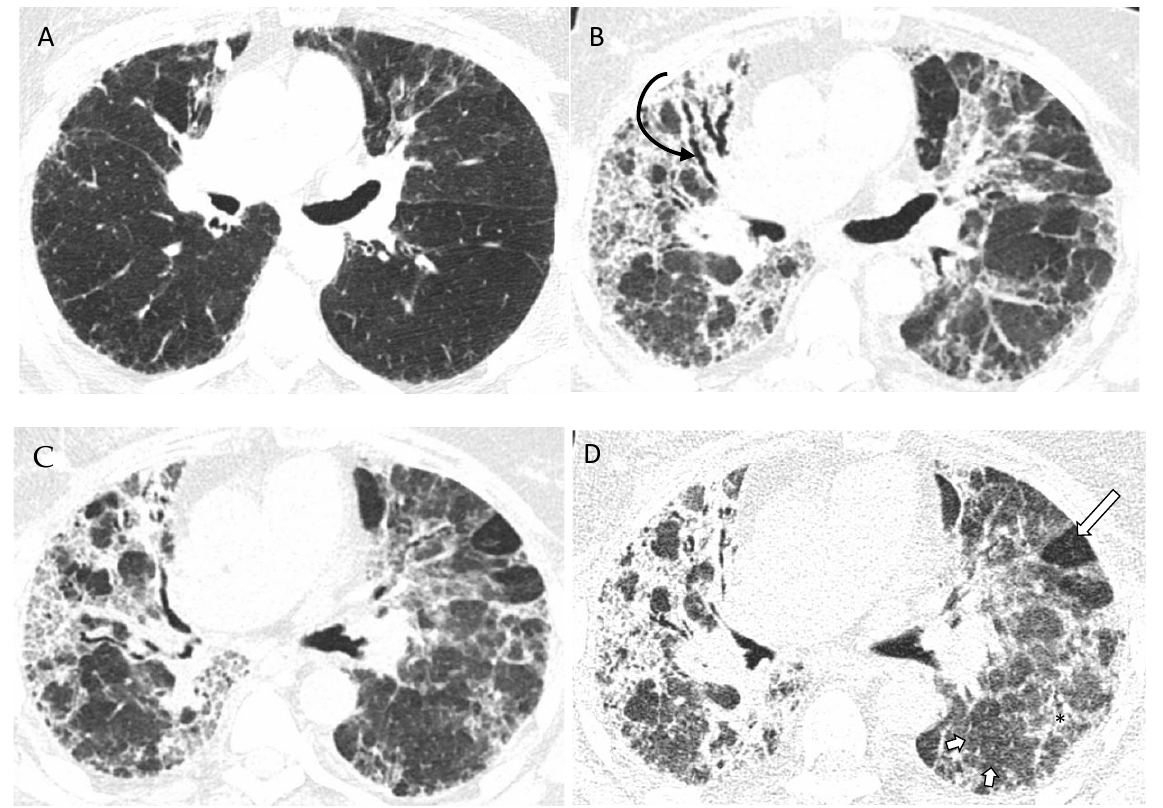
Figure 9. Typical fibrotic HP. Baseline CT ( A ) shows patchy GGOs. Follow up CT 3 years later ( B – D ) shows traction bronchiectasis (curved arrow), reticulations, patchy GGOs, and consolidations. Random axial and craniocaudal distribution of fibrosis. Axial inspiratory ( C ) and expiratory phase ( D ) shows three-density sign with expected increased attenuation of normal lung (short arrows) and GGOs (black asterisk). Lucent areas of decreased attenuation and vascularity depict air trapping (long arrow).